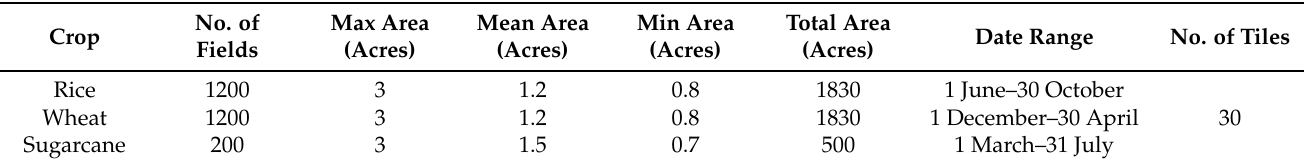
Table 2. Testbed Sentinel-2